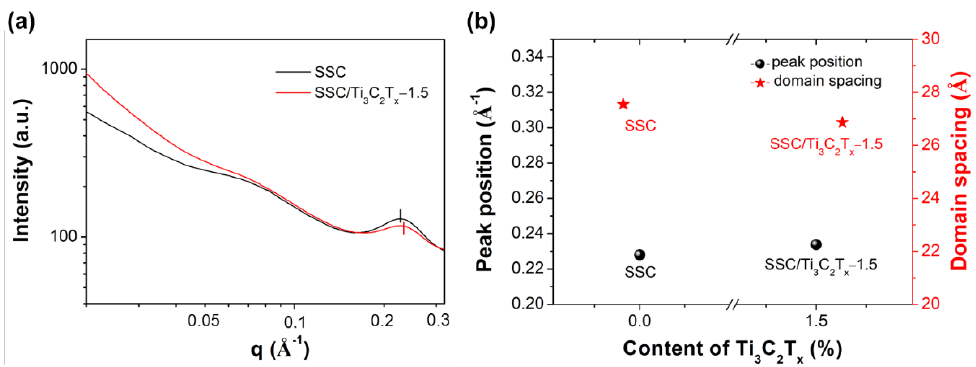
Figure 4. ( a ) 1D small angle X-ray scattering (SAXS) profiles of SSC and SSC/Ti 3 C 2 T x -1.5 mem- branes; ( b ) the Gaussian fitting results of SAXS profiles for ionic phase peaks (the peak between 0.2 to 0.3 Å − 1 ) of SSC and SSC/Ti 3 C 2 T x -1.5 membranes.